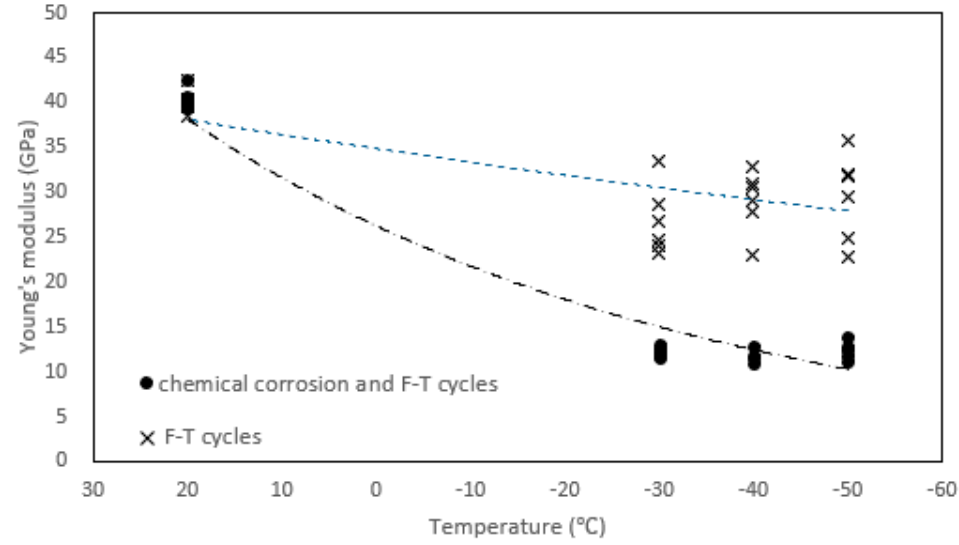
Figure 3. Young’s moduli of tonalite specimens from different groups.